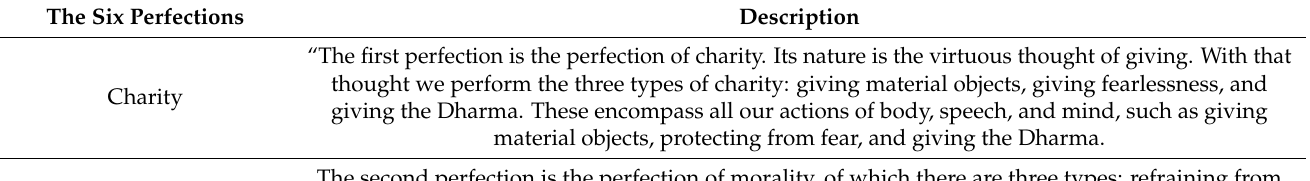
Table 2. The six perfections in Mahayana Buddhism.